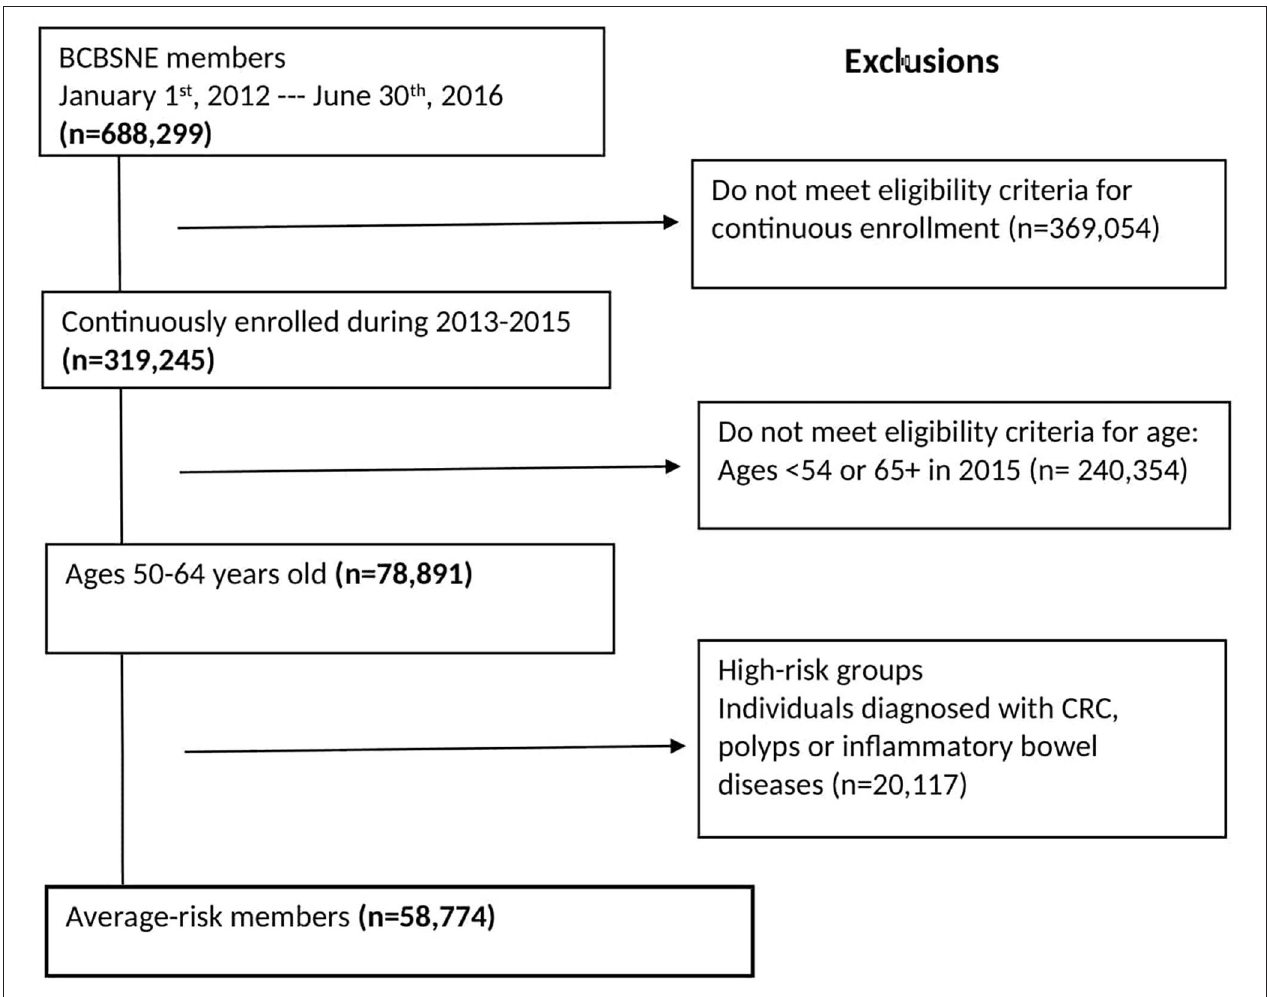
FIGURE 1 | Eligibility criteria for the study